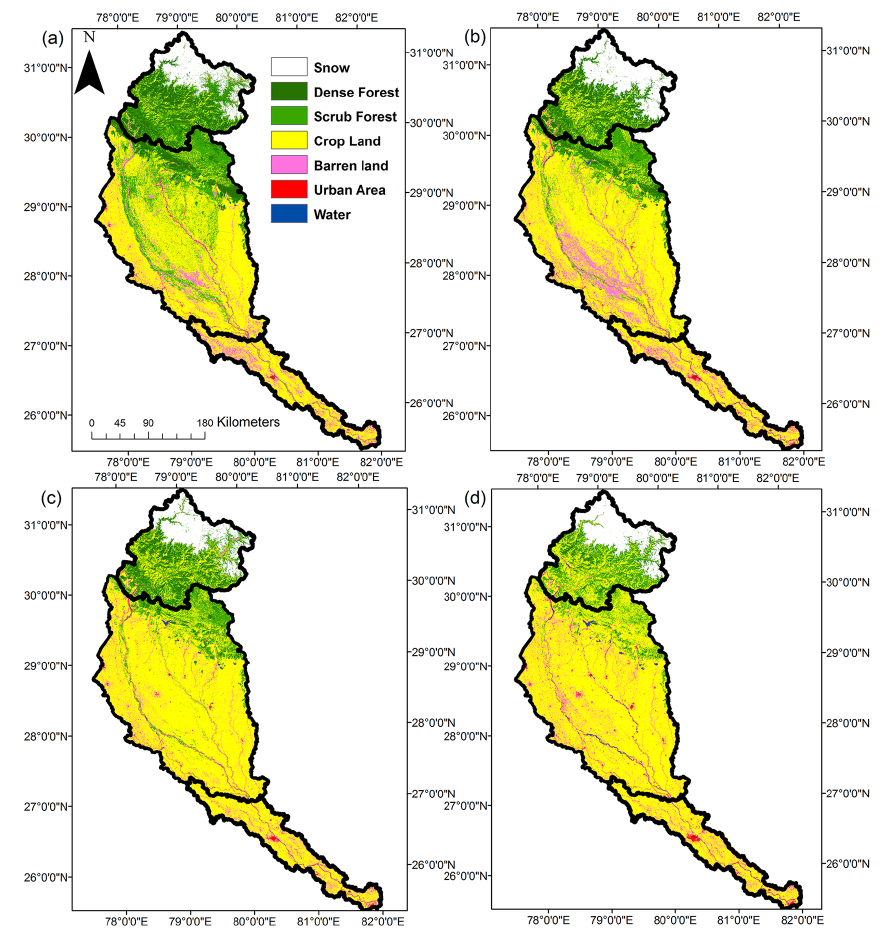
Figure 7. LU maps for (a) 1973, (b) 1980, (c) 2000 and (d)